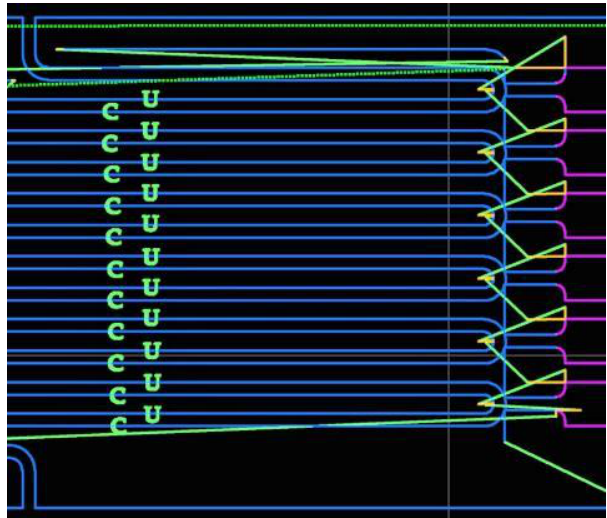
Figure 19. Tooth path for C-U cutting mode.